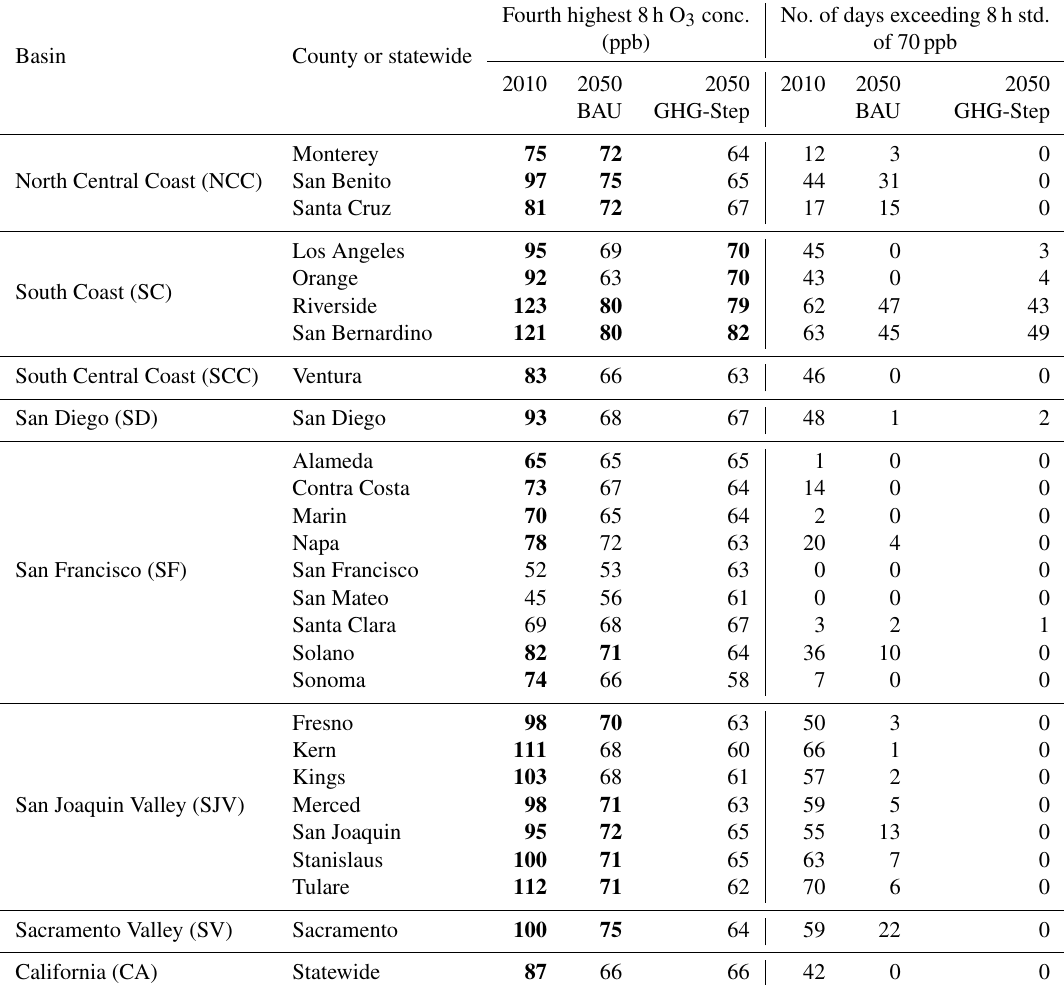
Table 1. The fourth highest maximum daily 8h average ozone concentration and number of days exceeding the standard during June–August months. Counties with fourth highest 8h ozone concentrations ≥ 70ppb are shown in bold. See Table S4 for 2010 O 3 designation values and